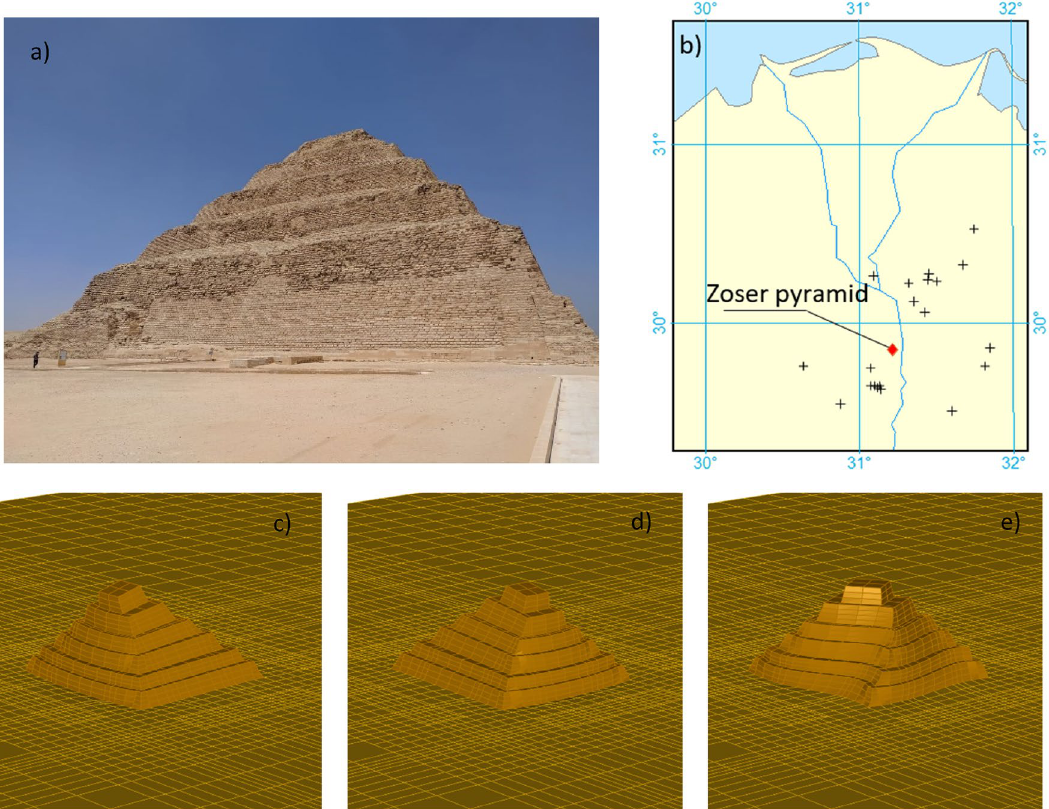
Figure 2. In panel ( a ) photography of the Zoser Pyramid investigated in this study; Panel ( b ) shows the epicentres (marked with “+”) of 24 earthquakes with magnitude M ≥ 3 occurred in and around the Greater Cairo Area and the location of the Zoser pyramid (“diamond”); Panels from ( c ) to ( e ) show the first three modal shapes of the numerical model of the Zoser